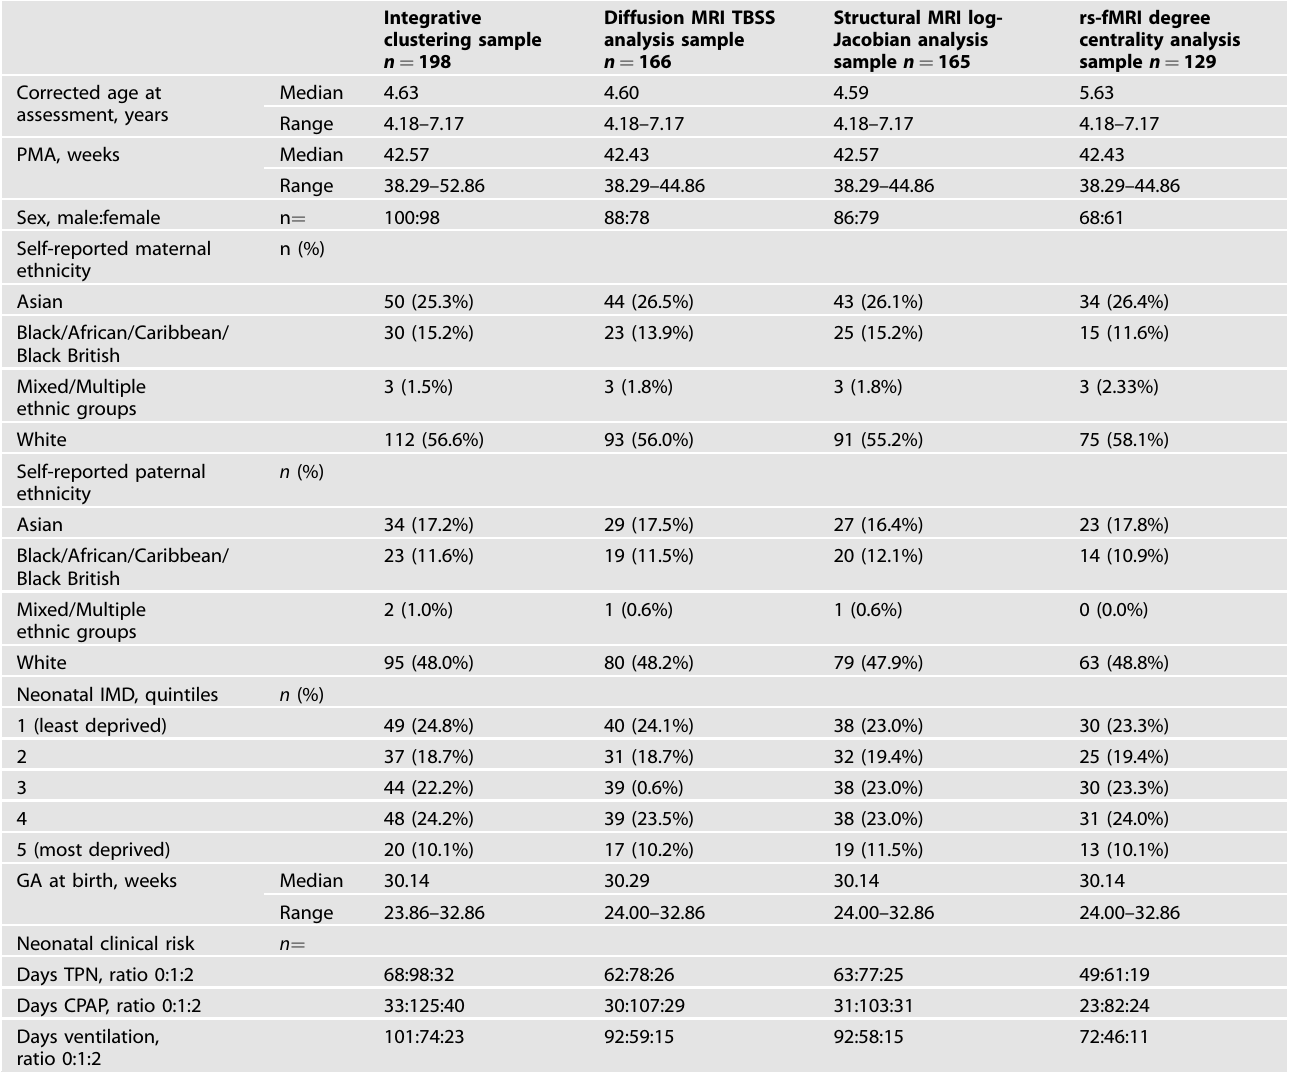
Table 1. Socio-demographic and clinical participant